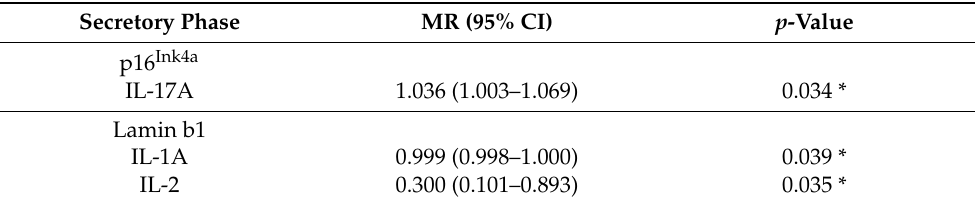
Table 3. Correlation between protein expression and cytokine expression (pg/mL) according to tissue type (non-endometriosis endometrium, eutopic endometrium, and endometriosis lesion). Secretory Phase MR (95% CI) p -Value p16 Ink4a IL-17A 1.036 (1.003–1.069) 0.034 * Lamin b1 IL-1A 0.999 (0.998–1.000) 0.039 * IL-2 0.300 (0.101–0.893) 0.035